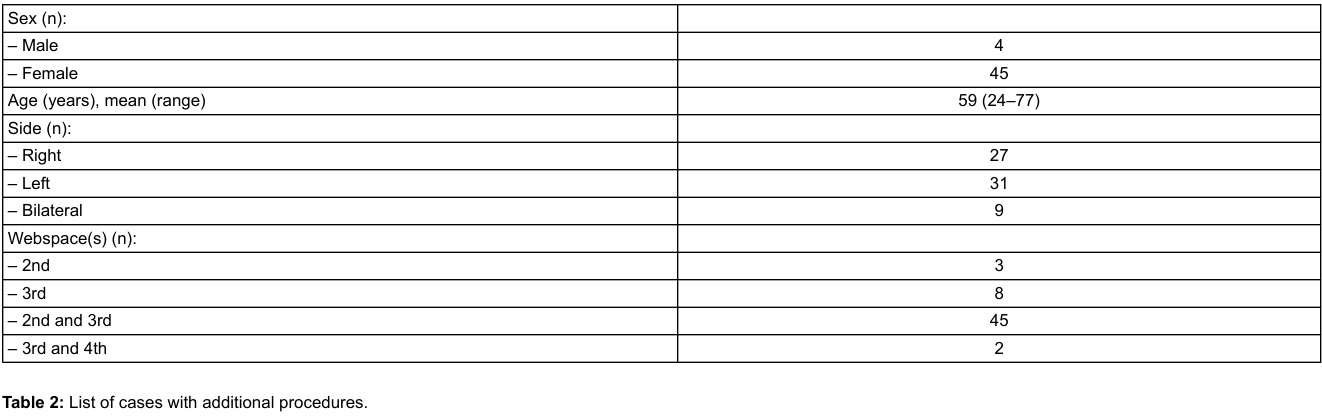
Table 2: List of cases with additional procedures. Additional procedures